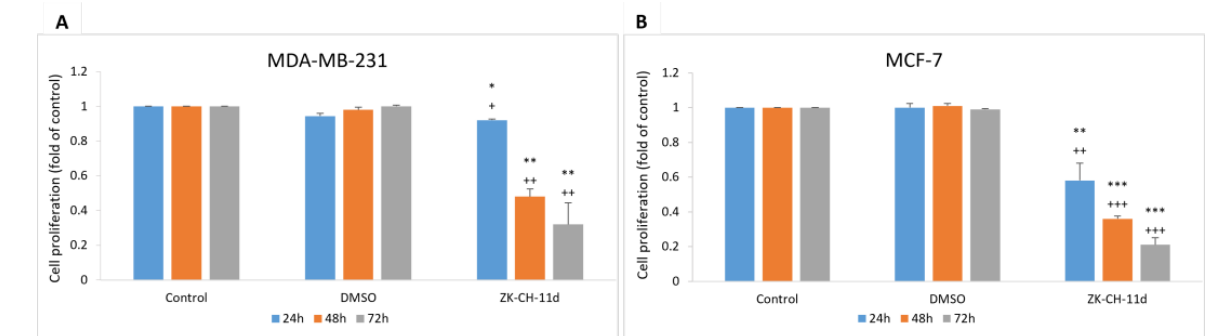
Figure 2. Effect of ZK-CH-11d on the proliferation of MDA-MB-231 ( A ) and MCF-7 ( B ) cells after 24, 48 and 72 h. The data are the results of three independent experiments. Values represent the mean ± standard deviation. Statistical significance: * p < 0.05, ** p < 0.01, *** p < 0.001 vs. DMSO; + p < 0.05, ++ p < 0.01, +++ p < 0.001 vs. untreated cells.